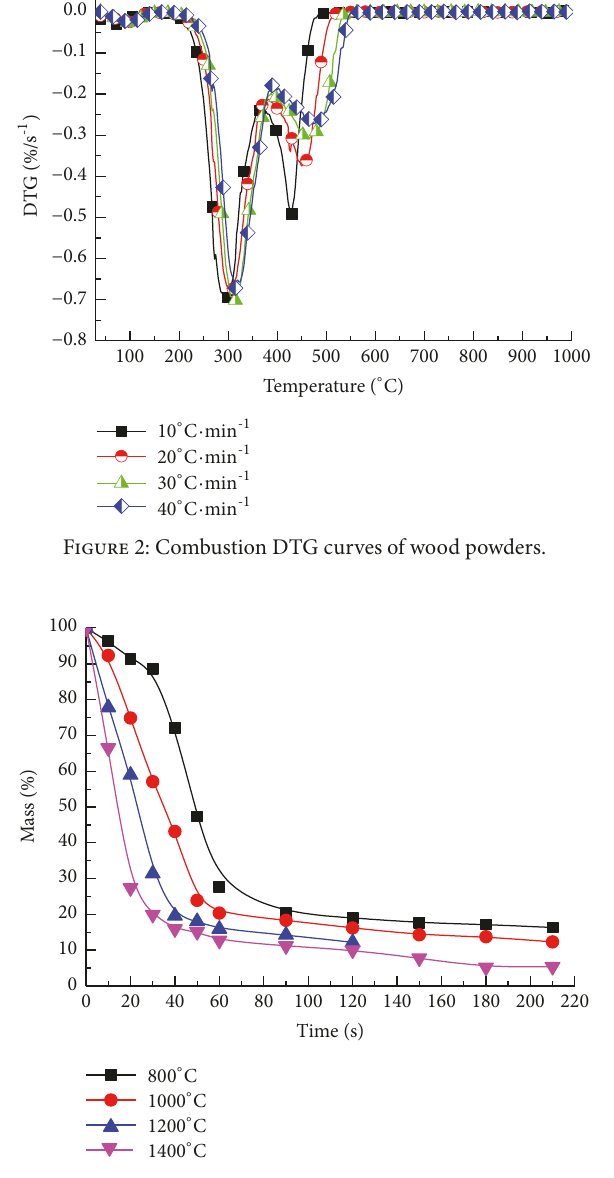
Global average 𝐸 and 𝐴 was 92.33 kJ mol −1 and 2.55 × 10 8 s −1 , respectively.